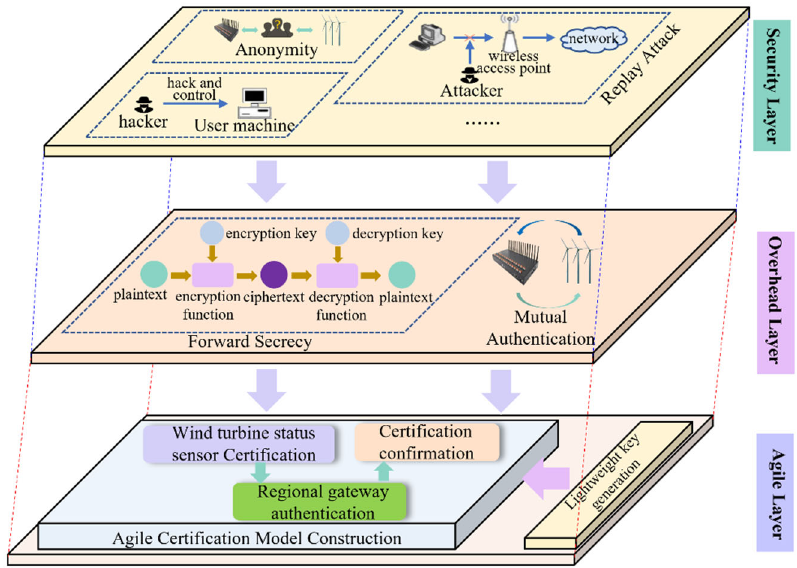
Figure 2. The demand analysis of wind turbine status sensor agile authentication.